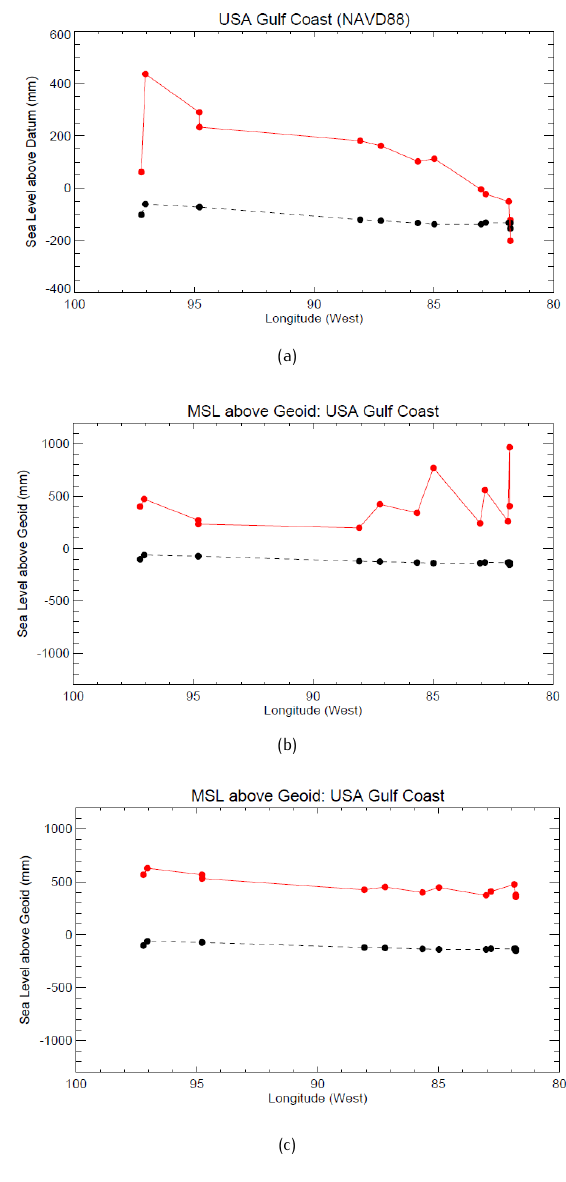
Figure 5. Corresponding information for the Gulf coastline. (a) MSL with respect to NAVD88, (b) geocentric MSL with respect to GOCO03S, and (c) geocentric MSL with respect to the ExtendedGOCO03Sgeoidmodel. NotethatKeyWesthas been included in Figures 2(a), 3(a), 4(a) and the present figure so as to provide a link between the Atlantic and Gulf